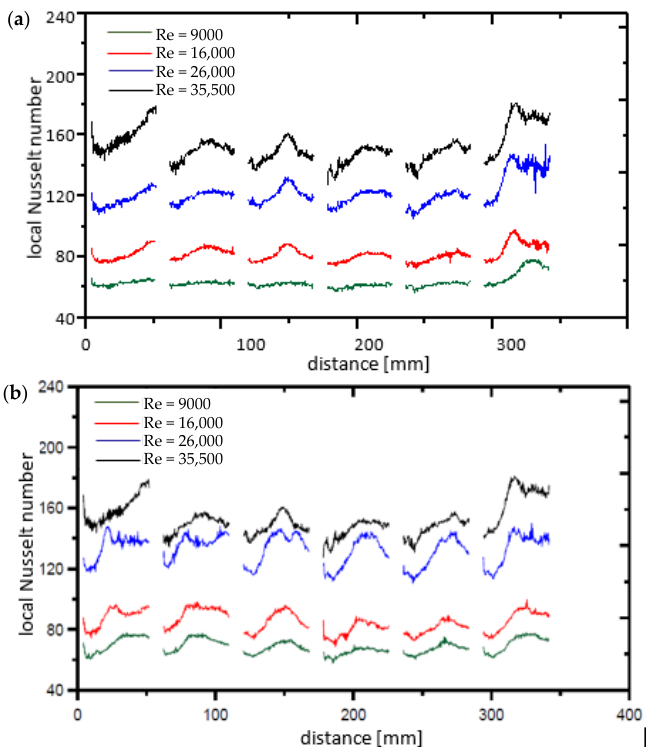
Figure 10. Local Nusselt numbers distributions for Re = 9,000; 16,000; 26,000 and 35,500 obtained by means of liquid crystal thermography (configuration_6): central zone ( a ) and wall zone ( b ).